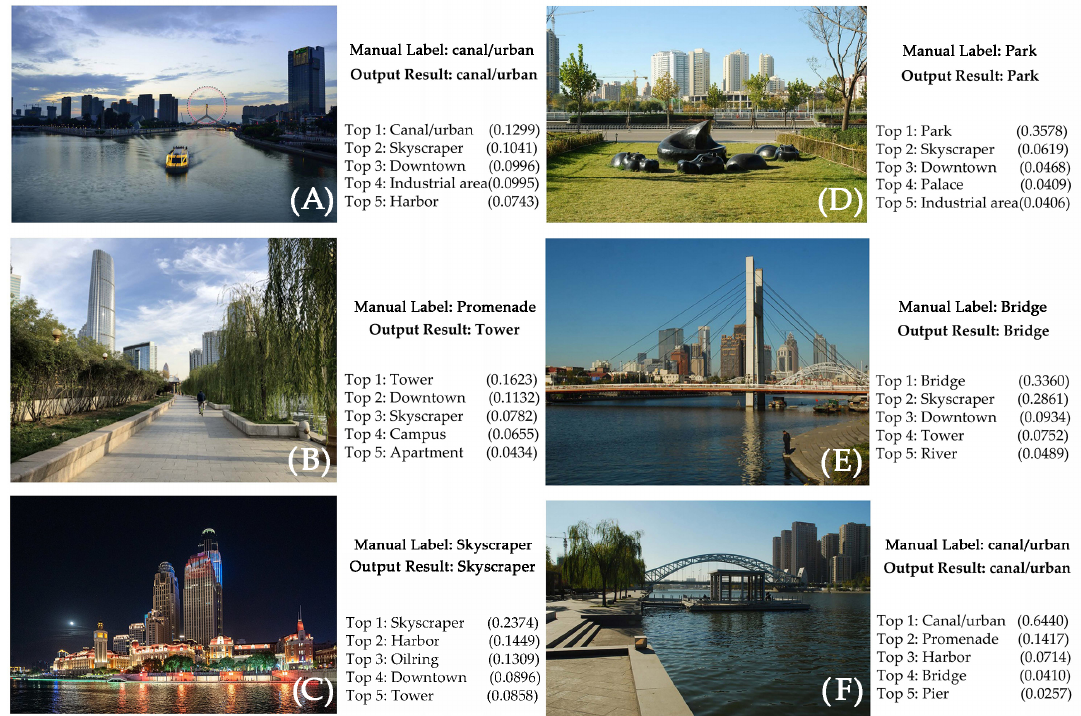
Figure 7. Prediction results of VGG-16 architecture for Flickr images.